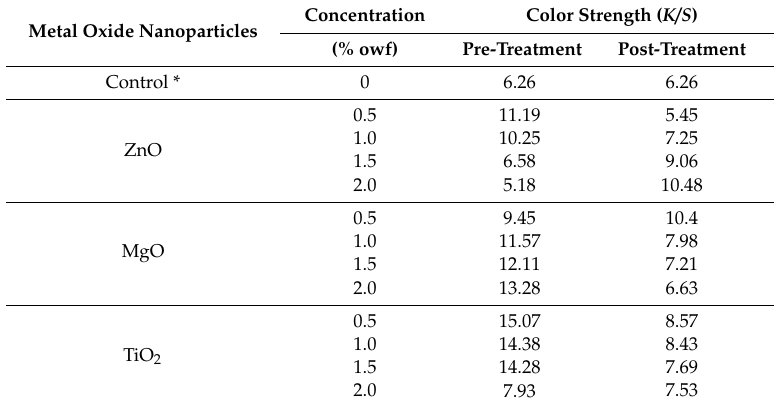
Table 3. E ff ect of pre- and post-treatment of wool fabrics with di ff erent metal oxide nanoparticles